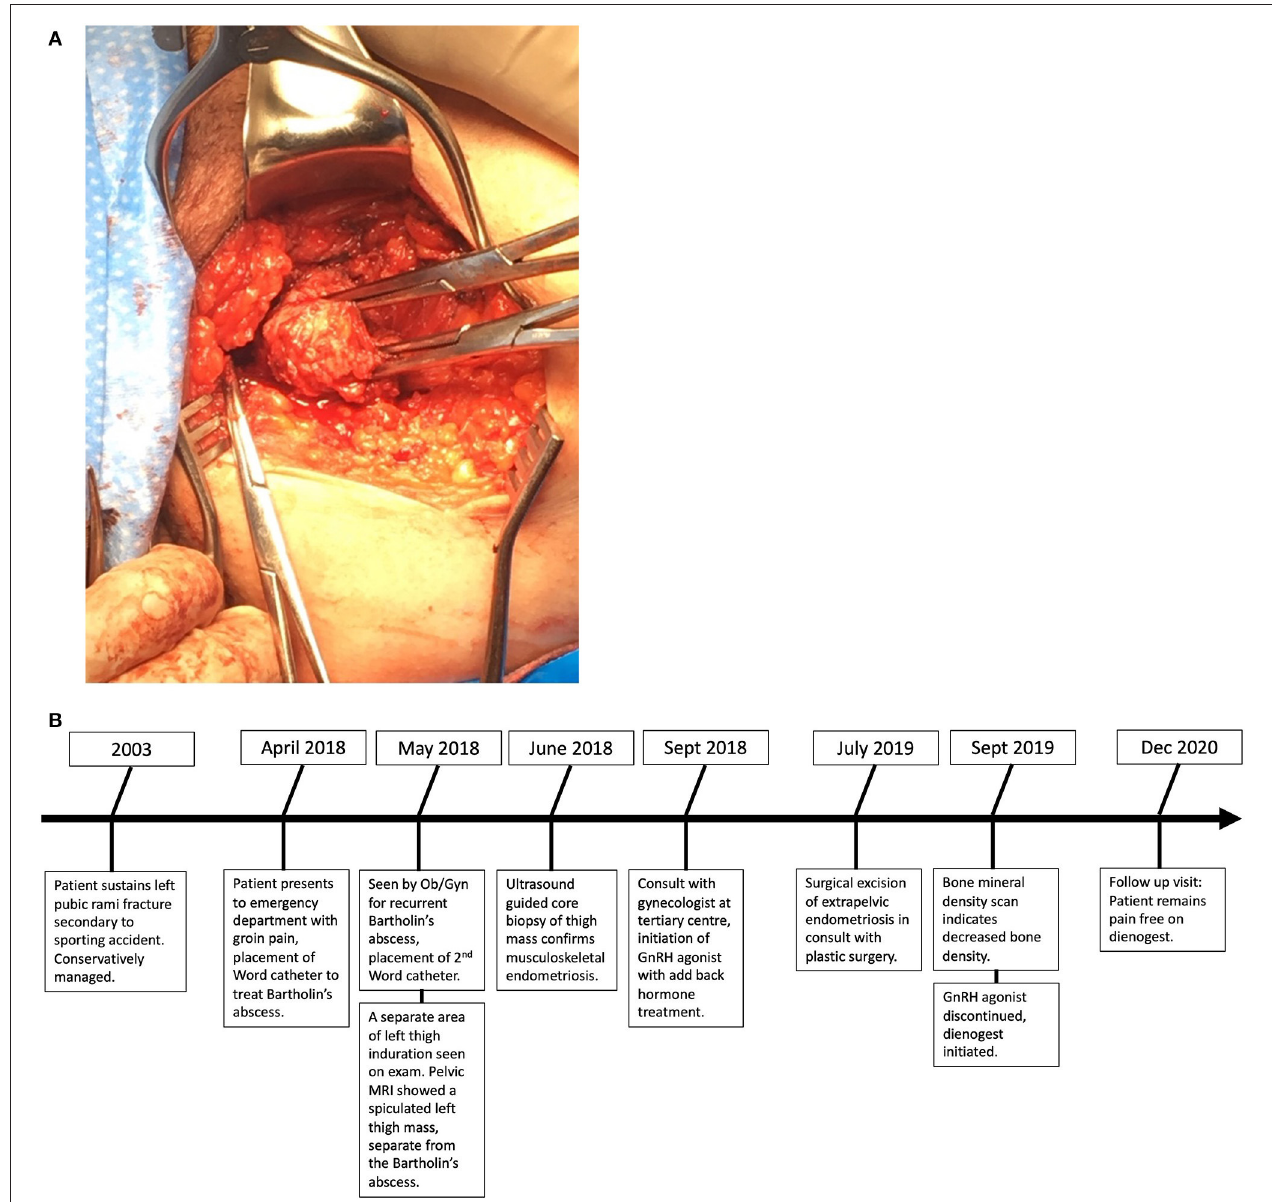
FIGURE 3 | (A) Intraoperative dissection of medial thigh compartment, highlighting the endometriotic lesion in the center. (B) Retrieved operative